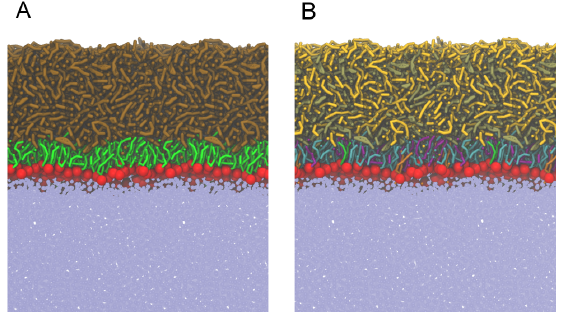
Figure 2. Typical snapshots of the laterally relaxed system (APPL=68 A˚ 2 ). An overall side-view with water beads shown in ice- blue, non-polar lipids in brown, headgroups of polar lipids in red, and tails of polar lipids in green (A); a detailed view of individual lipid components: TG in gold, CE in tan, POPC tails in cyan, POPE tails in purple, SM tails in orange, Cer tails in green, and all polar headgroups in red (B). For presentation purposes, in each snapshot two periodic images in the lateral direction are depicted (corresponding to about 22 nm).